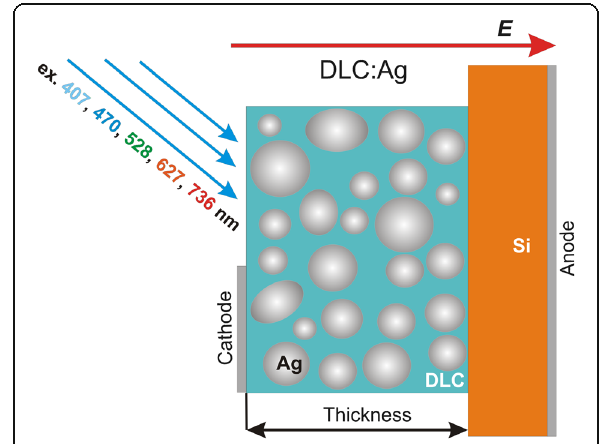
Fig. 1 Schematic diagram of the sample used for studies of the photovoltaic properties of DLC:Ag/Si heterostructures